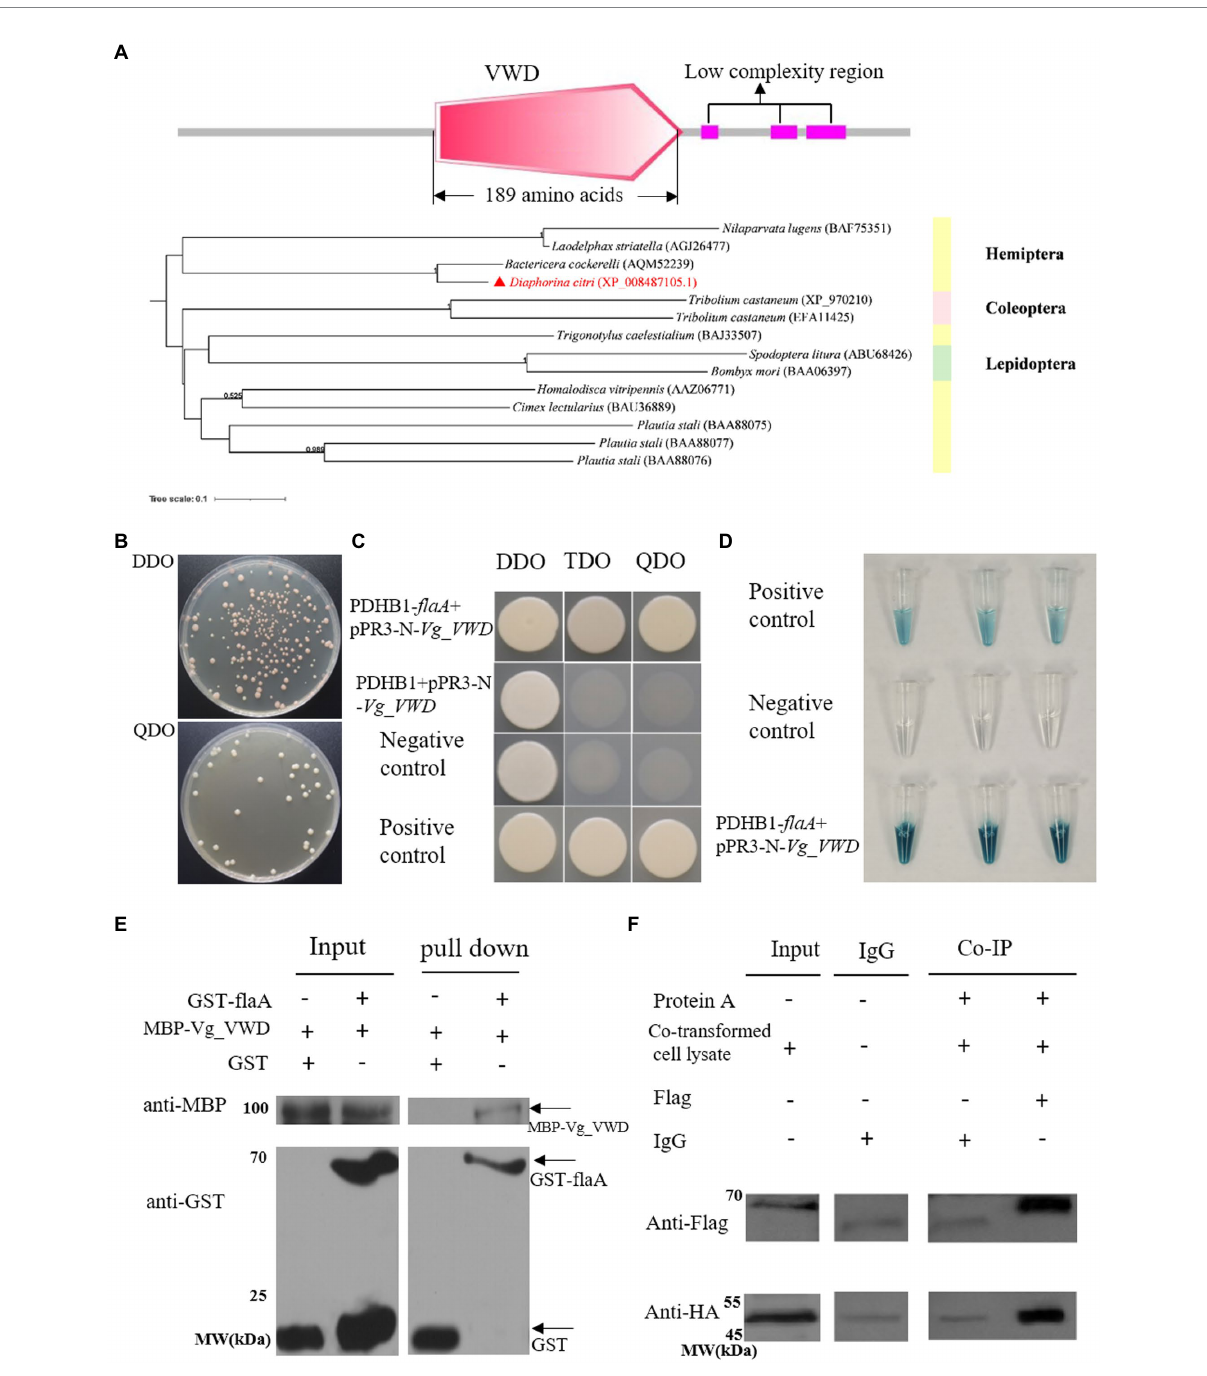
FIGURE 1 C Las flagellum (flaA) interacts with D. citri vitellogenin-like (Vg_VWD) and its molecular characterization. (A) The structural domain analysis of the Vg_VWD protein sequence and a phylogenetic tree containing Vg_VWD and other selected homologs from analysis by SMART software showed a VWD-conserved structural domain. (B) Yeast-two hybrid (Y2H) assay for the growth of yeast strain co-transformed with the bait and prey plasmids on DDO and QDO media. (C) The bait plasmid PDHB1- flaA and the prey-plasmid pPR3-N- Vg_VWD were co-transferred into NMY51 yeast, spotted on DDO, TDO, and QDO, and grow normally on selection medium TDO and QDO. PDHB1 + pPR3-N- Vg_VWD was verified for self-activation of the prey-plasmid and failed to grow on selection medium TDO and QDO. (D) Yeast cultures were blue in the β -galactosidase assay. The well-grown test yeasts were selected separately and subjected to overnight incubation in a DDO liquid medium, after which crude protein was extracted and the concentrations tested. Approximately 75 μ L of crude protein was added to 5 μ L of x-gal and incubated at 37 ° C for 2 h to observe the color change and photograph. (E) GST pull-down assay demonstrating the interaction of flaA with Vg_VWD. GST-flaA was the bait, and GST alone served as the control, with MBP-Vg_VWD serving as the prey. The bait protein or the GST control was incubated with MBP-Vg_VWD protein. Input and pull-down samples were probed with antibodies against GST or MBP for Western blot assays. (F) Co-IP detection of flaA interacting with Vg_VWD in Sf9 cells. Sf9 cells were transfected with the indicated plasmid combinations and the proteins were present in the lysate supernatant of Sf9 cells. The input group detected the target proteins in the lysate of co-transfected cells: Vg_VWD + Flag and HA + flaA with protein molecular weights of 65.1 kDa and 51.2 k Da, respectively. The IgG group excluded the heavy chain interference generated by protein A and IgG antibodies. The co-IP group was immunoprecipitated with Flag antibody (murine monoclonal antibody), IgG was used as control, and after WB analysis, the arrow marks the position of the target